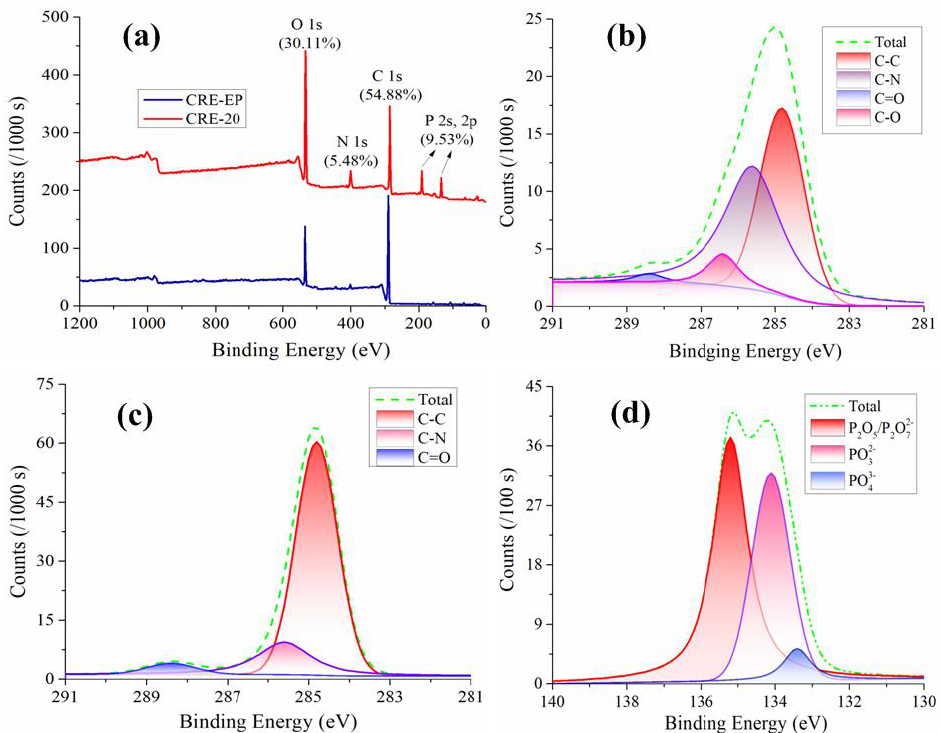
Figure 7. XPS spectra of CREs: ( a ) high-magnification XPS survey spectra of CRE-EP and CRE-20; ( b ) peak-fitting curves of C1s in CRE-EP; ( c ) peak-fitting curves of C1s in CRE-20; ( d ) peak-fitting curves of P2p in CRE-20.